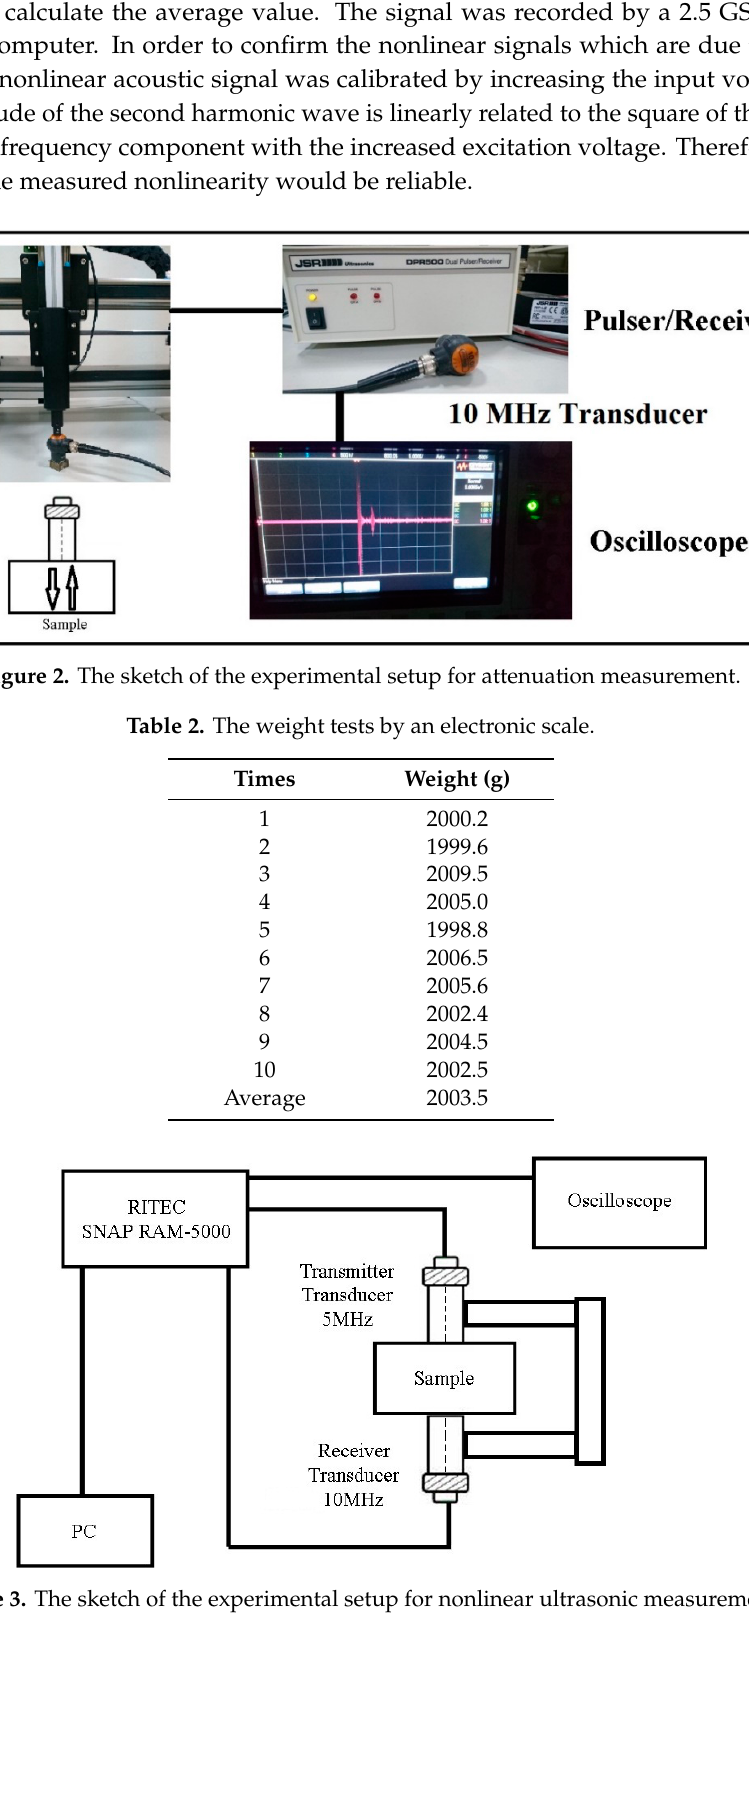
Fundamental wave Figure 4. The amplitudes of the fundamental and second harmonics from the fast Fourier transform (FFT). Second harmonic